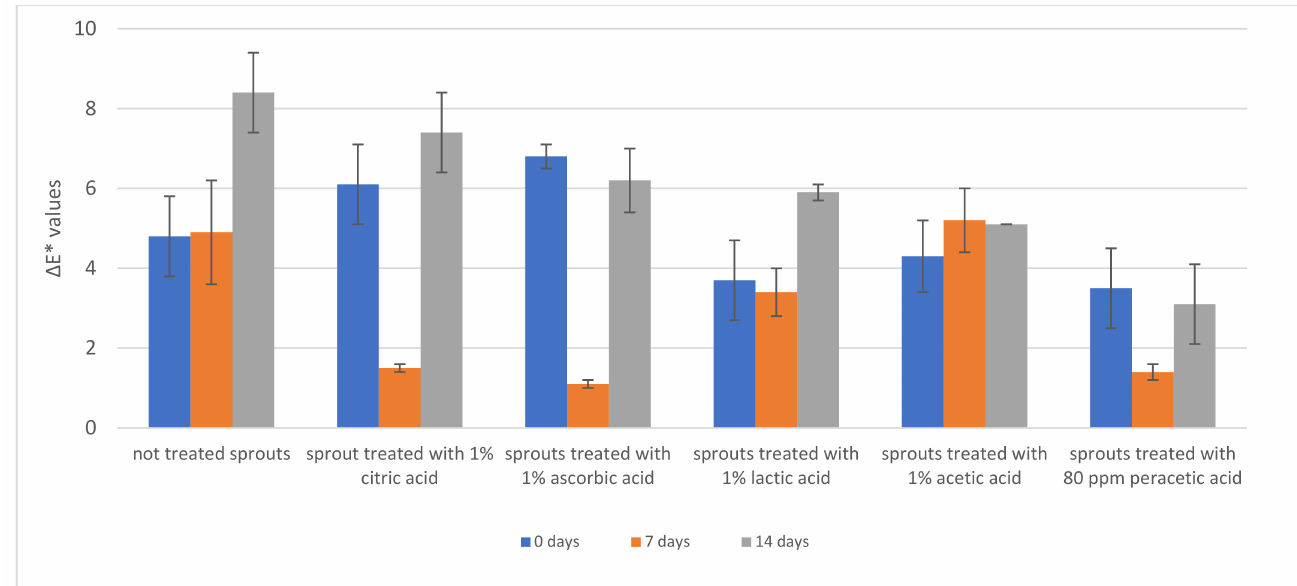
Figure 4. Color changes ( ∆ E* values) of red cabbage sprouts with the addition of solutions of various organic acids subjected to 14-day storage. The graph shows the mean values and standard deviation ( n =